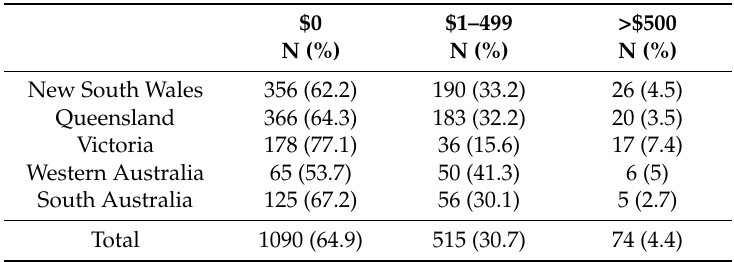
Table 6. Price range of cats advertised on Gumtree between 7 and 26 February 2016 and their Australian State or Territory. Percentages represent the proportion of cats within that State/Territory in each price category.